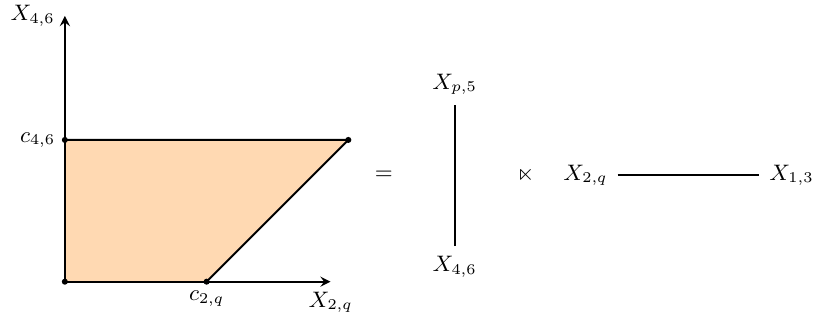
Figure 3 . The facet geometry of X 1 , 4 in A [(1 , 2) , 3 , (4 , 5) , 6] . The geometry is the semi-direct product of two bounded lines: A [(1 , 2) , 3 , q ] n A [ p, (4 , 5) , 6] . If it were a direct product, the geometry would be a